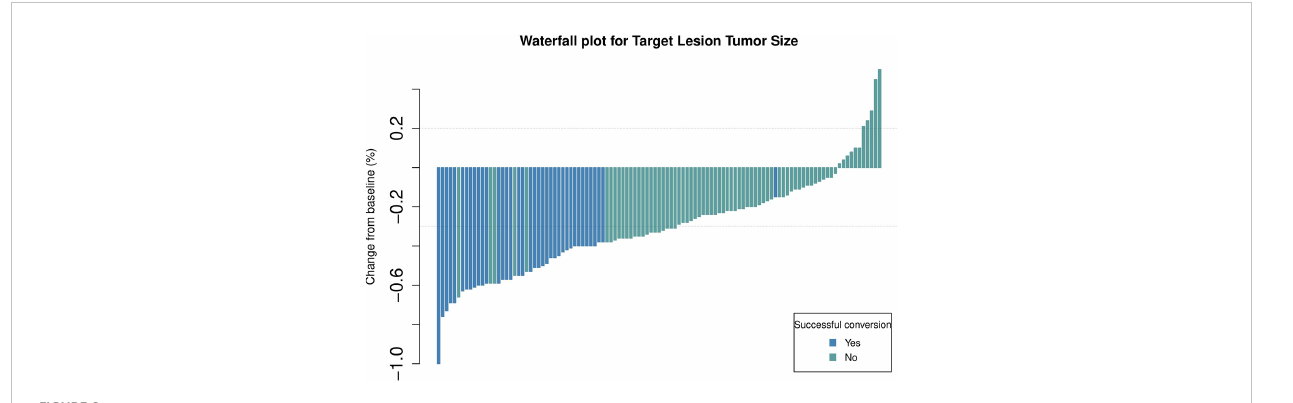
FIGURE 2 Waterfall plot demonstrating the target lesion size estimated using mRECIST